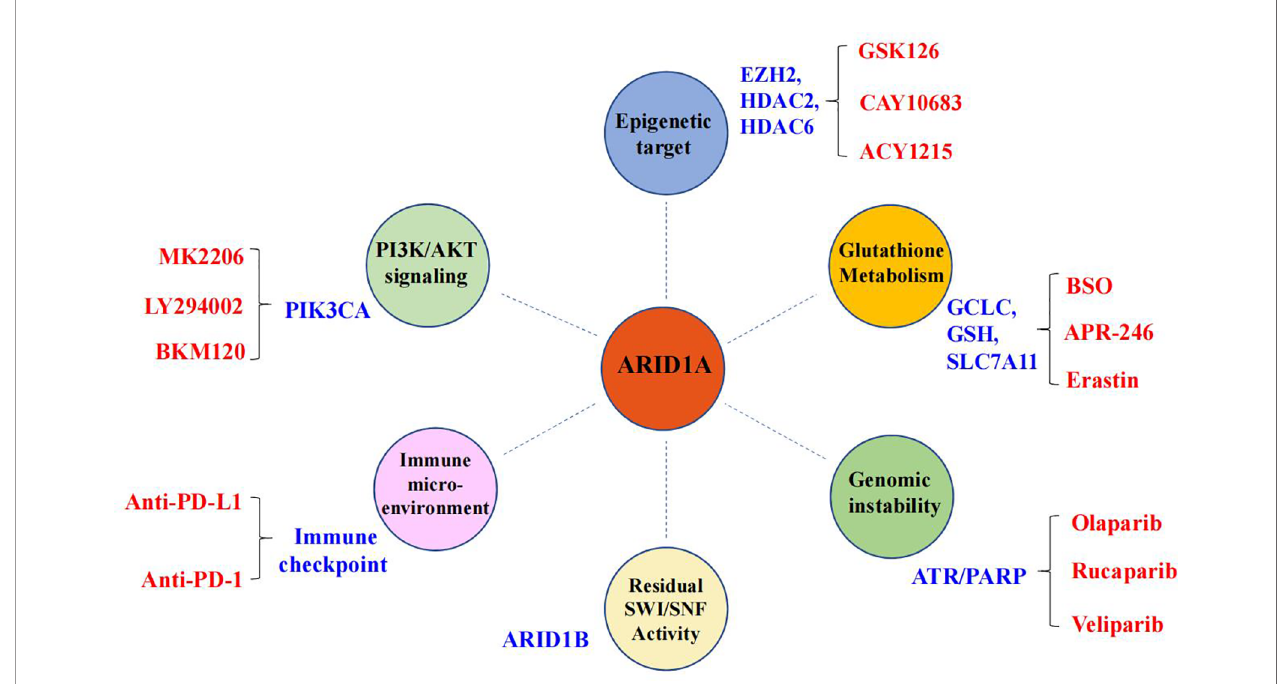
FIGURE 2 | Synthetic lethal targets of ARID1A de fi ciency. The drug targets are listed in blue, and the speci fi c names of drugs are labeled in